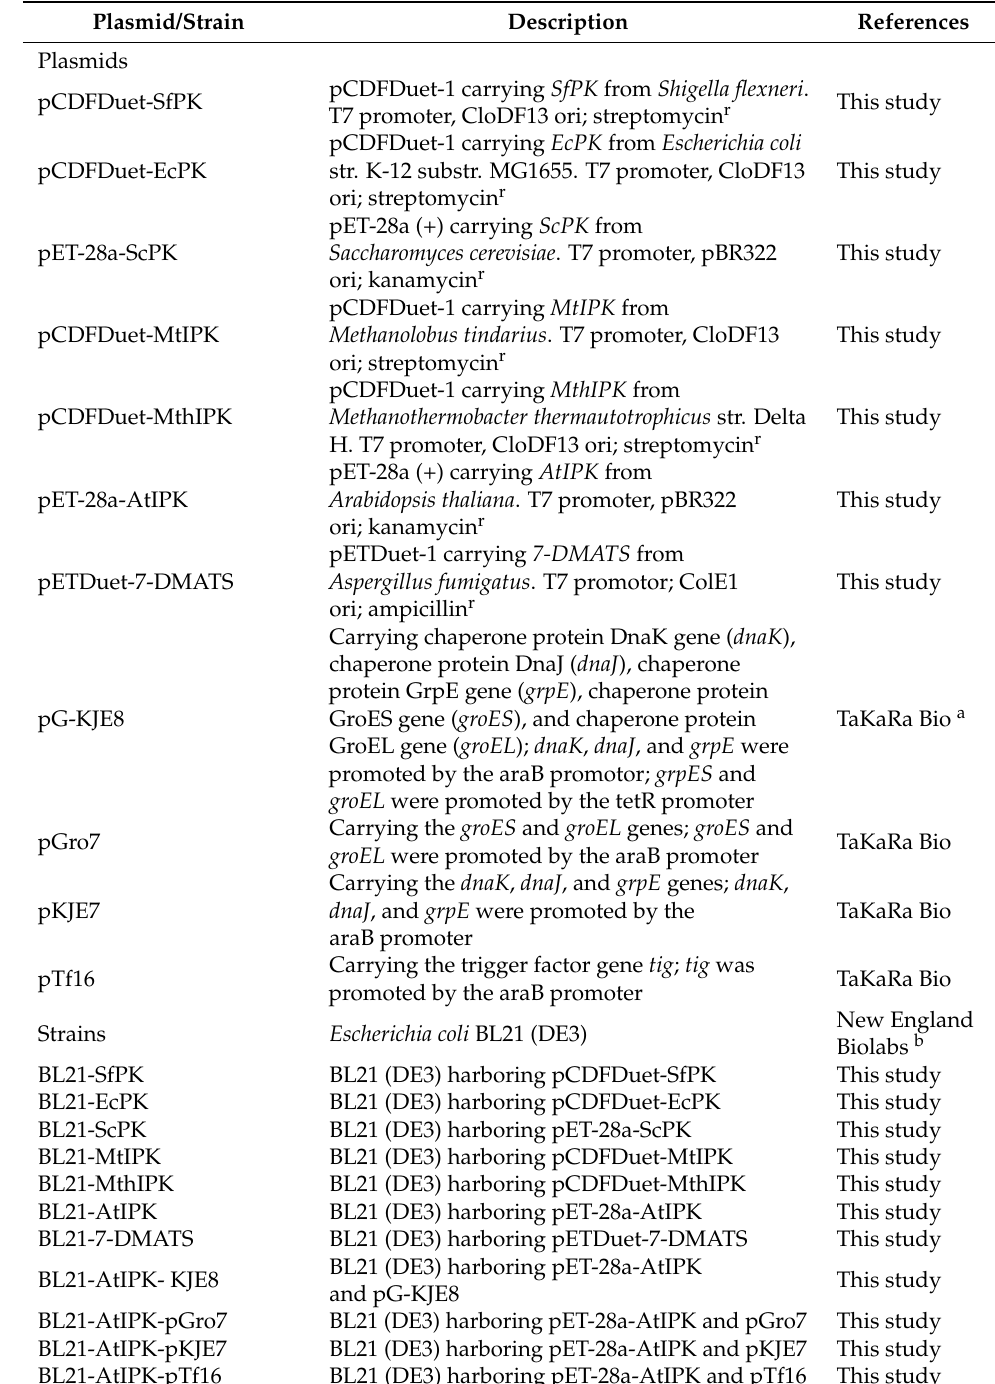
Table 4. Plasmids and strains used in this